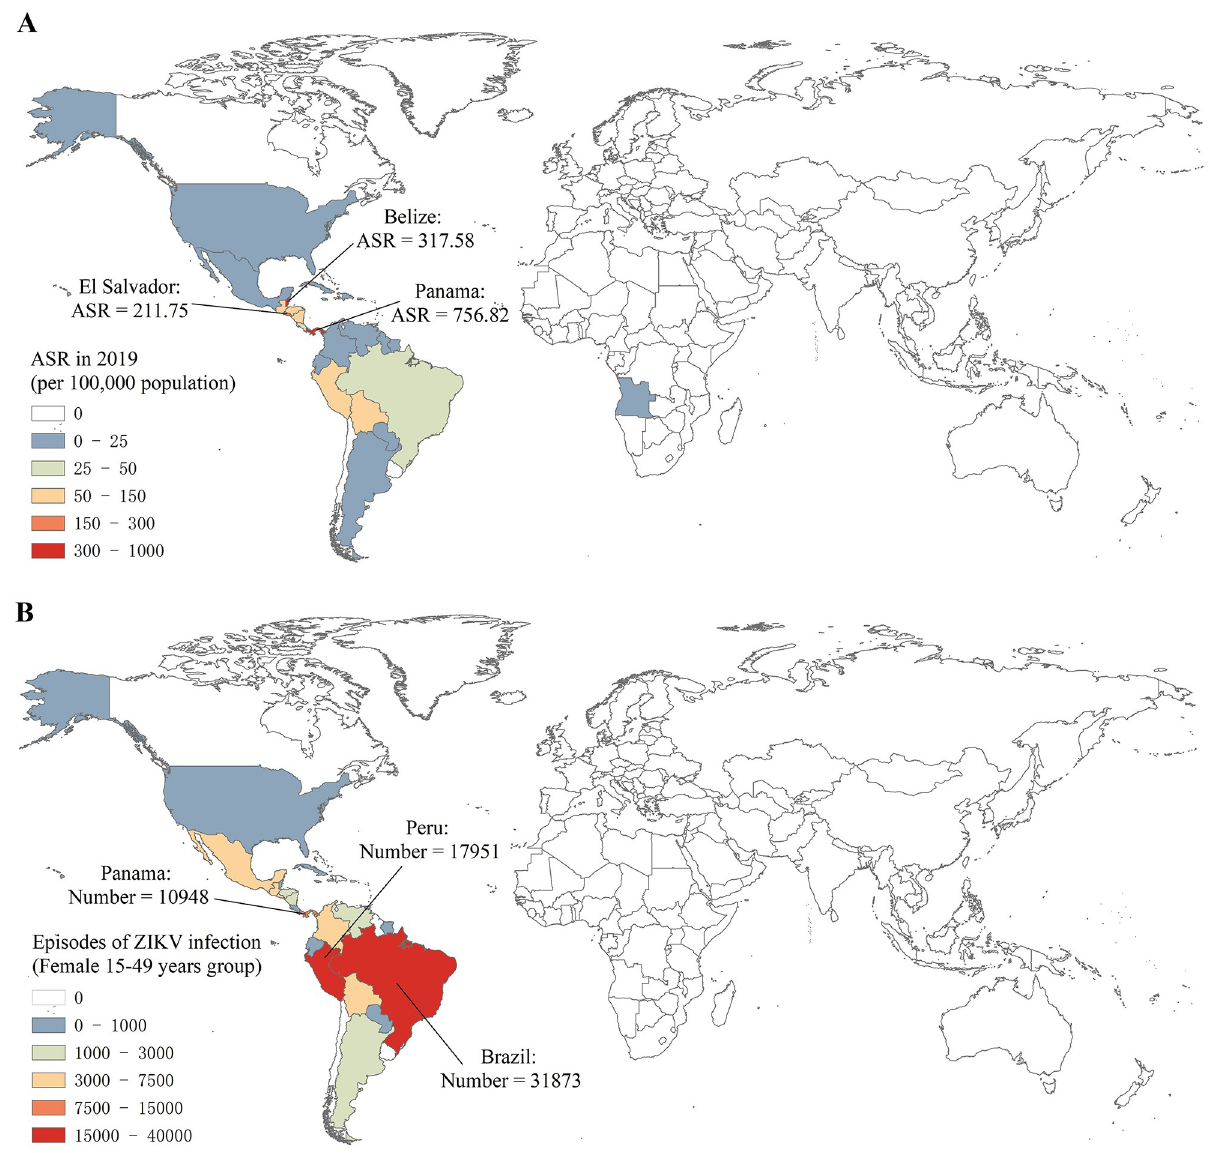
Fig 1. The global incidence of ZIKV infection in 204 countries and territories in 2019. (A) The ASRs of ZIKV infection in 2019; (B) The episodes ZIKV infection of female with age between 15 to 49 in 2019. Global and local mapping were presented using the ArcGIS software. Basemap shapefile’s map content from http://bzdt.ch.mnr.gov.cn/, approval number GS (2016)